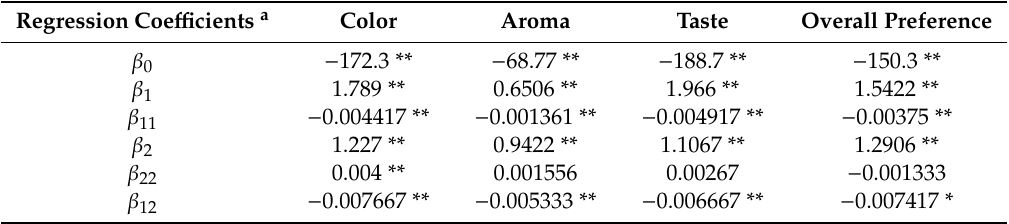
Table 8. Regression coe ffi cients of the second order polynomial equation for the sensory attributes of full-fat brew.